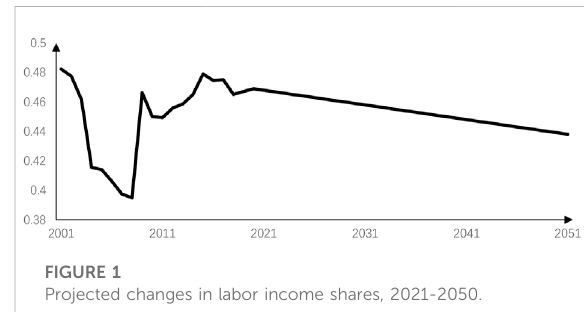
FIGURE 1 Projected changes in labor income shares, 2021-2050.